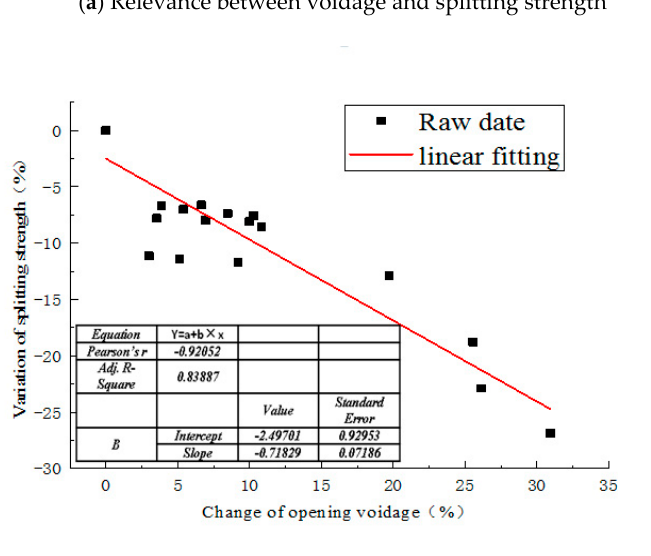
Figure 12. Relevance between void and splitting strength.